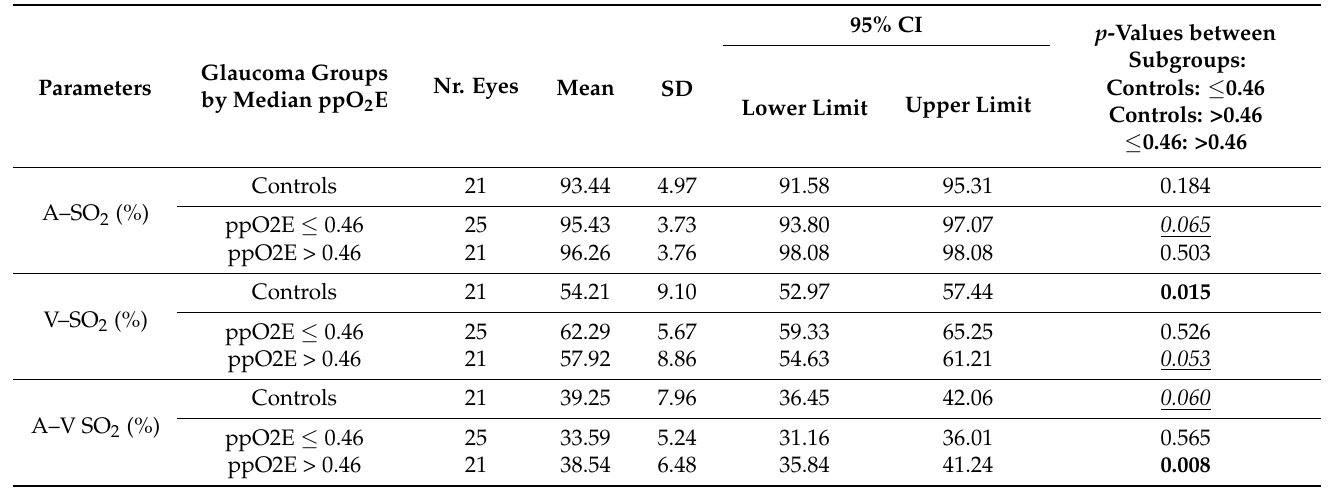
Table 5. Peripapillary oxygen exposure (ppO 2 E; %/ µ m) of controls against both glaucoma groups, where the glaucoma group is divided by oxygen consumption into ppO 2 E group with ≤ 46%/ µ m and ppO 2 E group with >46%/ µ m. Statistically significant values are given in bold and those showing a trend: in italics